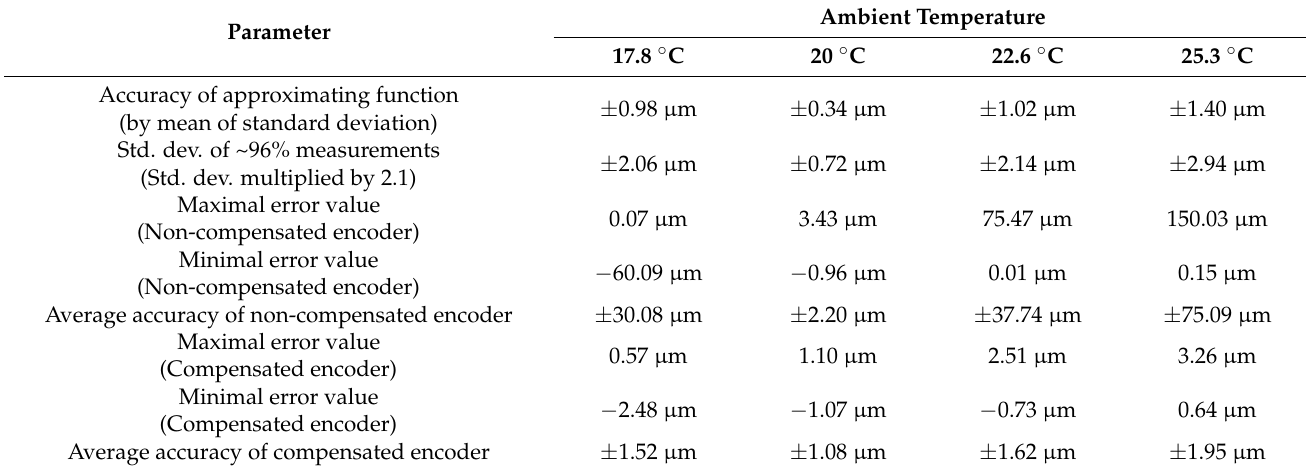
Figure 7. Combined average accuracy graph of uncompensated linear encoder average error at different ambient temperatures, and their compensation functions calculated according the presented mathematical algorithm. Table 3. Parameters of approximating function and compensated tested encoder accuracy graphs.